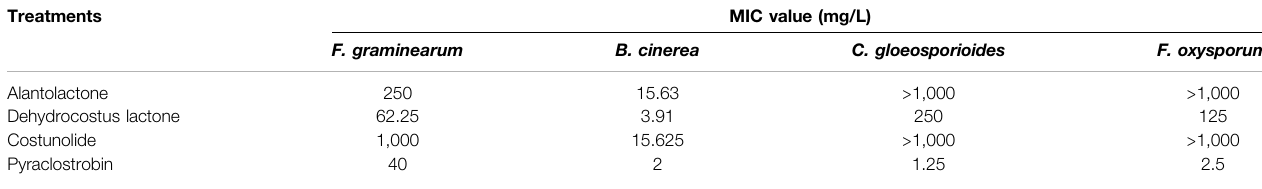
TABLE 7 | MIC values of active compounds of Radix Aucklandiae against four plant-pathogenic fungi.